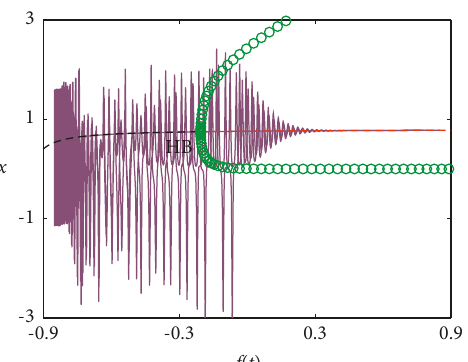
Figure 3: Transformed phase portrait on the plane of dashed lines correspond to stable and unstable steady state, respectively. The green unfilled points represent the amplitude of the limit cycle oscillation. Other parameter values are fixed same as in Figure 1.